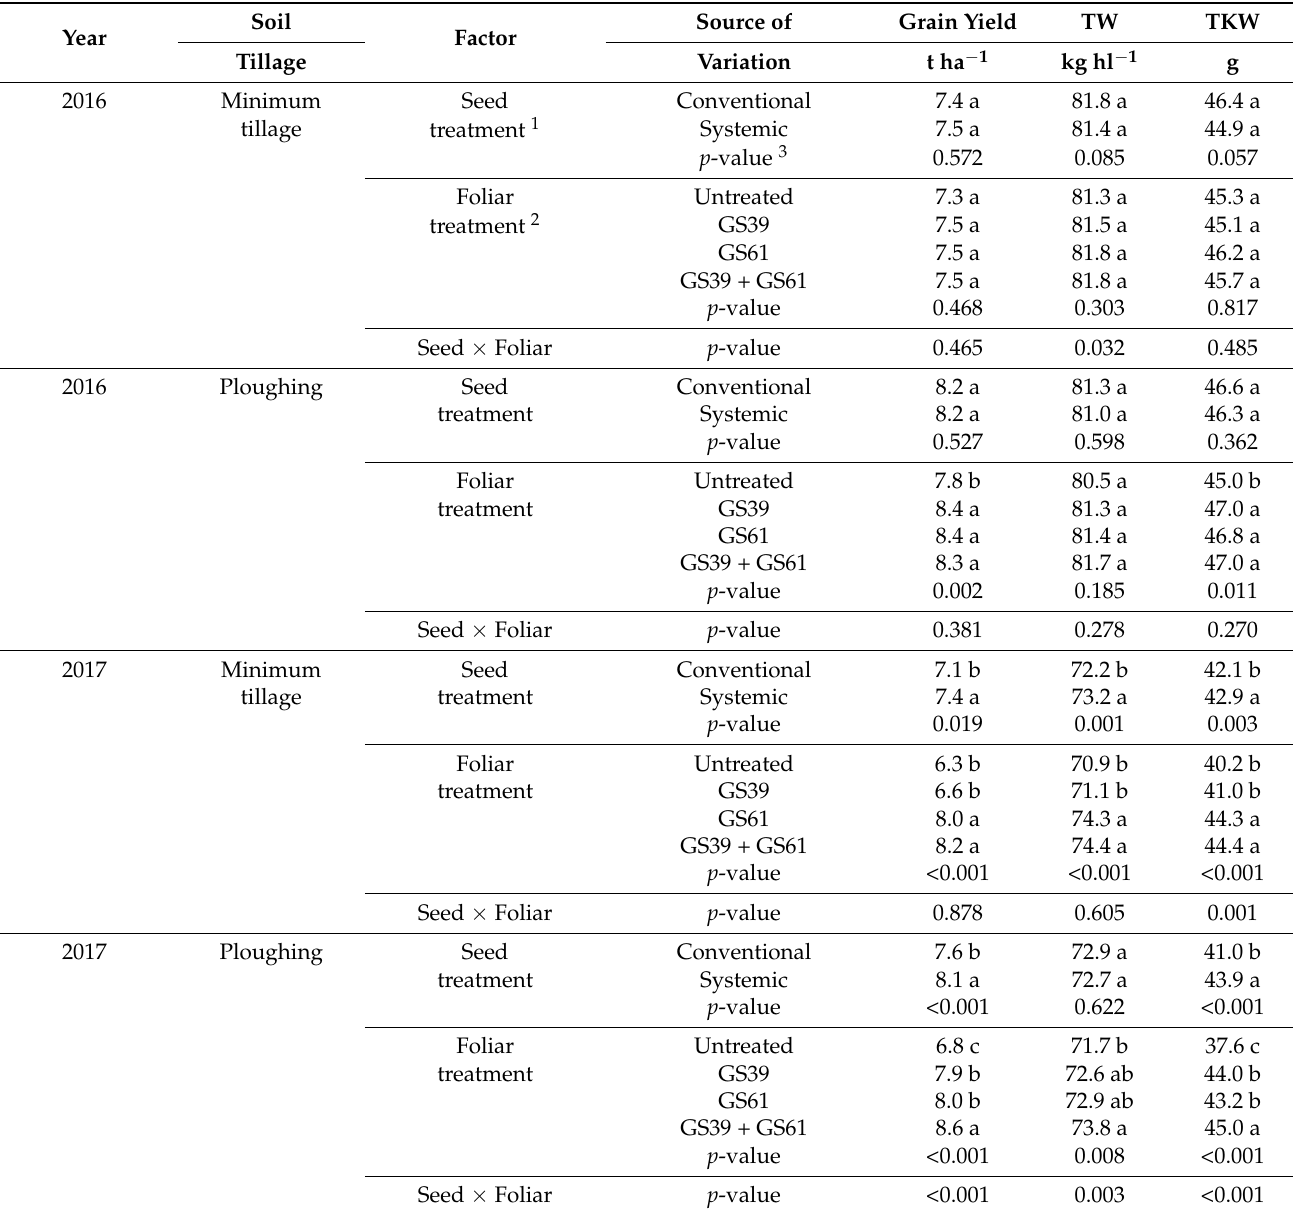
Table 4. Effect of the fungicide seed and foliar treatments on the grain yield, test weight (TW) and thousand kernel weight (TKW) in the 2015–2016 and 2016–2017 growing seasons in